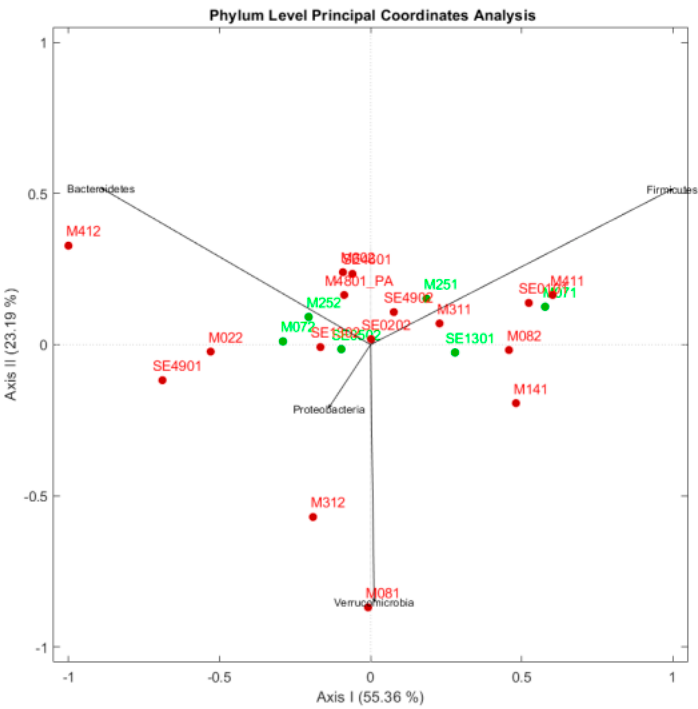
Figure 4. Beta diversity analyses at the phylum level: PCoA based on Bray–Curtis distance measure. Green: OSA − atherosclerosis. Red: OSA + atherosclerosis.